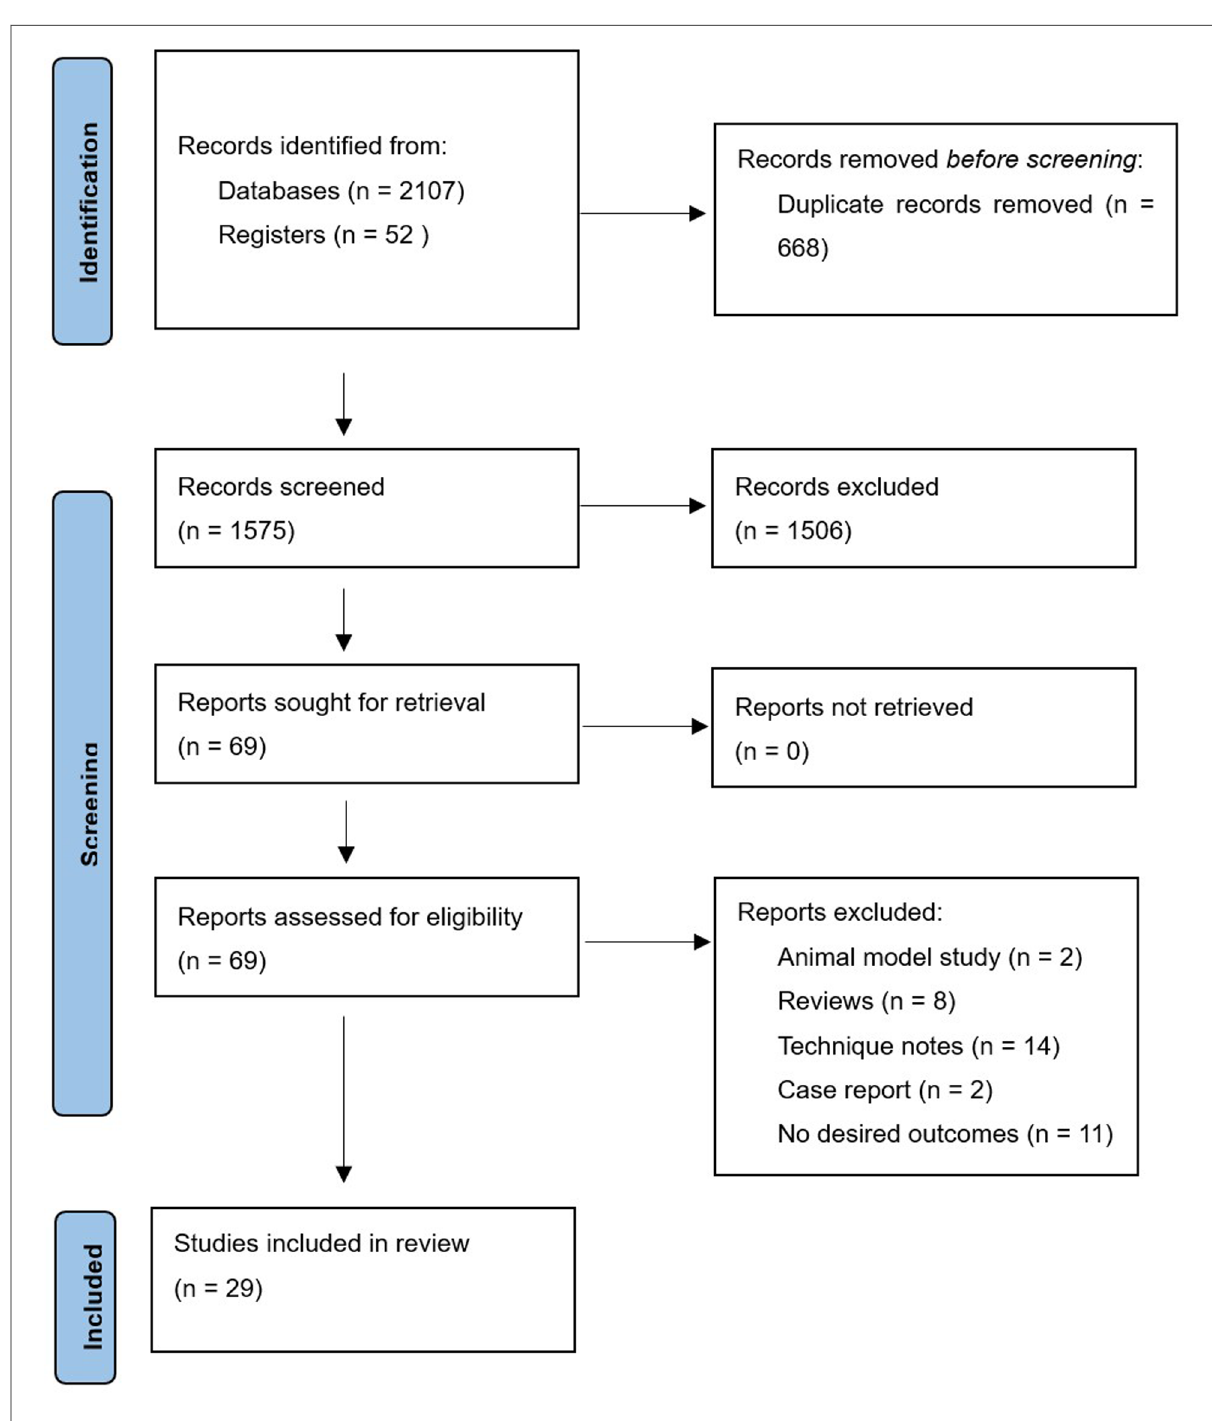
FIGURE 1 Flow diagram of literature